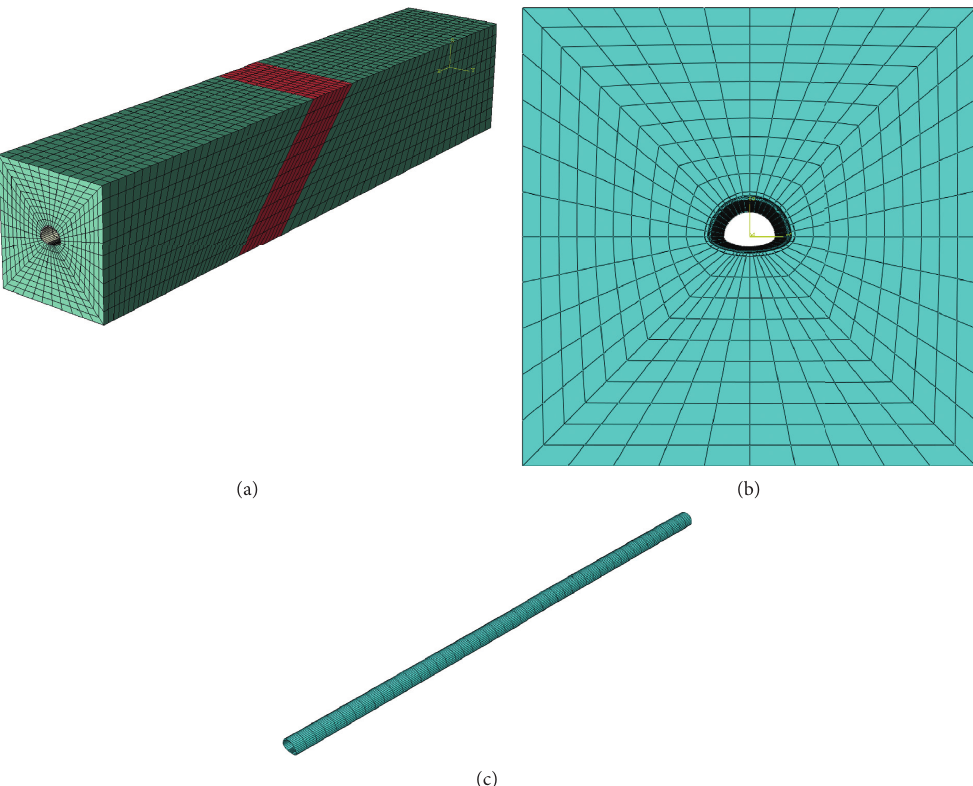
Figure 3: The meshing diagram of calculation model. (a) The meshing diagram of the overall calculation model. (b) The meshing diagram of the transverse section of the calculation model. (c) The meshing diagram of tunnel